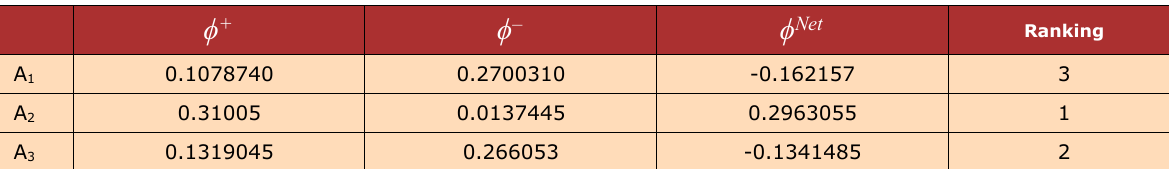
Table 5. F-PROMETHEE flows